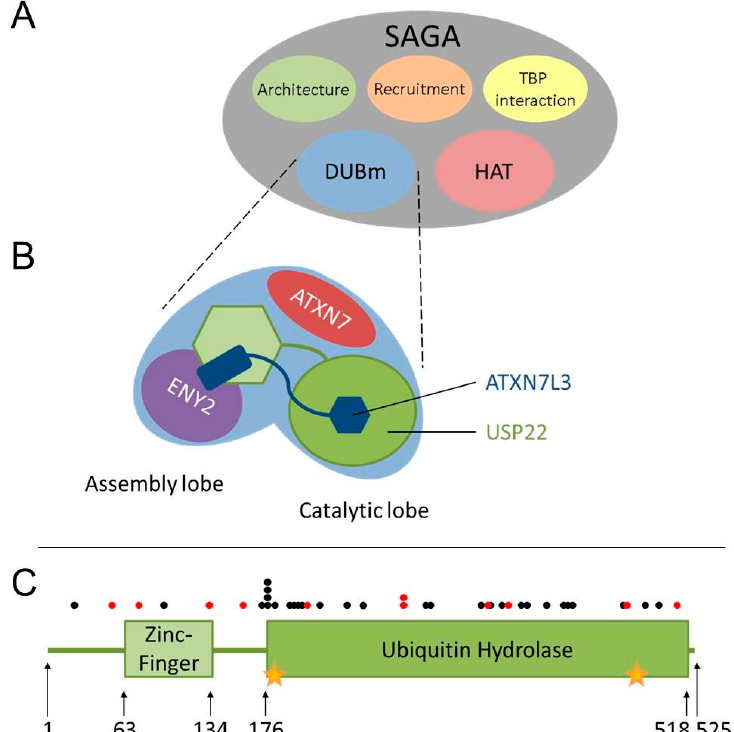
Figure 2. The SAGA complex ubiquitin hydrolase, USP22, is frequently mutated in cancer. ( A ) SAGA is a multi-module protein complex with two catalytically-active modules: the histone acetyl transferase (HAT) module and the deubiquitinase module (DUBm). TBP: TATA-binding protein. ( B ) The DUBm assembly lobe is formed by ENY2 and the USP22 N-terminal zinc-finger motif (green hexagon) structured around the N-terminal helix of ATXN7L3 (blue rectangle), while ATXN7 anchors the DUBm to the rest of SAGA. The catalytic lobe is comprised of the C-terminal ubiquitin hydrolase domain of USP22 (green circle) and the N-terminal zinc-finger domain of ATNX7L3 (blue hexagon). ( C ) Schematic depiction of the protein domains within USP22 along with the positions (circles) of cancer-associated alterations. Arrows indicate the starting positions (amino acid residues) of the protein and its domains. Stars identify the position of the two key evolutionarily-conserved catalytic residues, Cys185 and His479. Circles indicate the positions of amino acid substitutions (black) and non-sense/frame-shift mutations (red) [37].